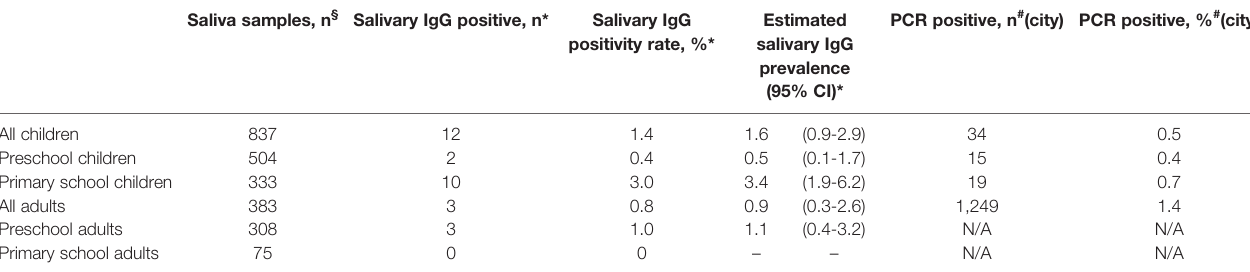
TABLE 4 | Salivary SARS-CoV-2 IgG prevalence and infections within the pandemic year 2020 in Tübingen city. Saliva samples, n § Salivary IgG positive,